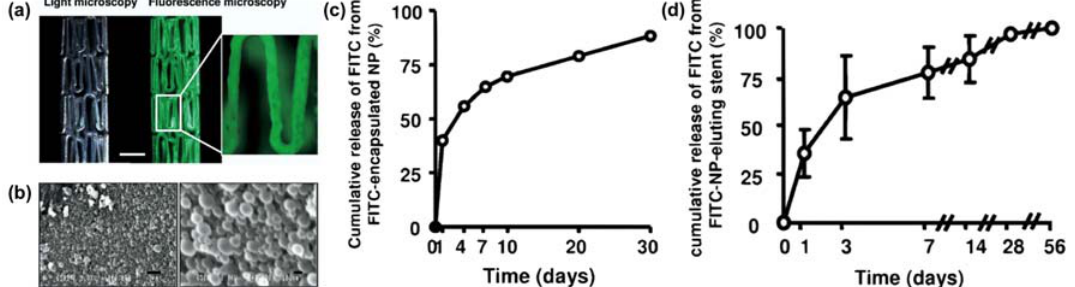
Figure 3. Fabrication of a fluorescence marker enabled nanoparticle ‐ eluting stents using cationic electrodeposition coating technology. ( a ) Light and fluorescence microscopic images of fluorescence marker enabled nanoparticle ‐ eluting stents. Scale bar = 1 mm. ( b ) Scanning electron microscopic image showing the nanoparticle ‐ eluting stents (scale bar: left = 1 μ m; right = 100 nm). ( c ) In vitro cumulative release profile of Fluorescein Isothiocyanate (FITC) (a fluorescence marker) encapsulated nanoparticles. ( d ) In vitro cumulative release profile of FITC (a fluorescence marker) from nanoparticles ‐ eluting stents. Reproduced with permission from [105].